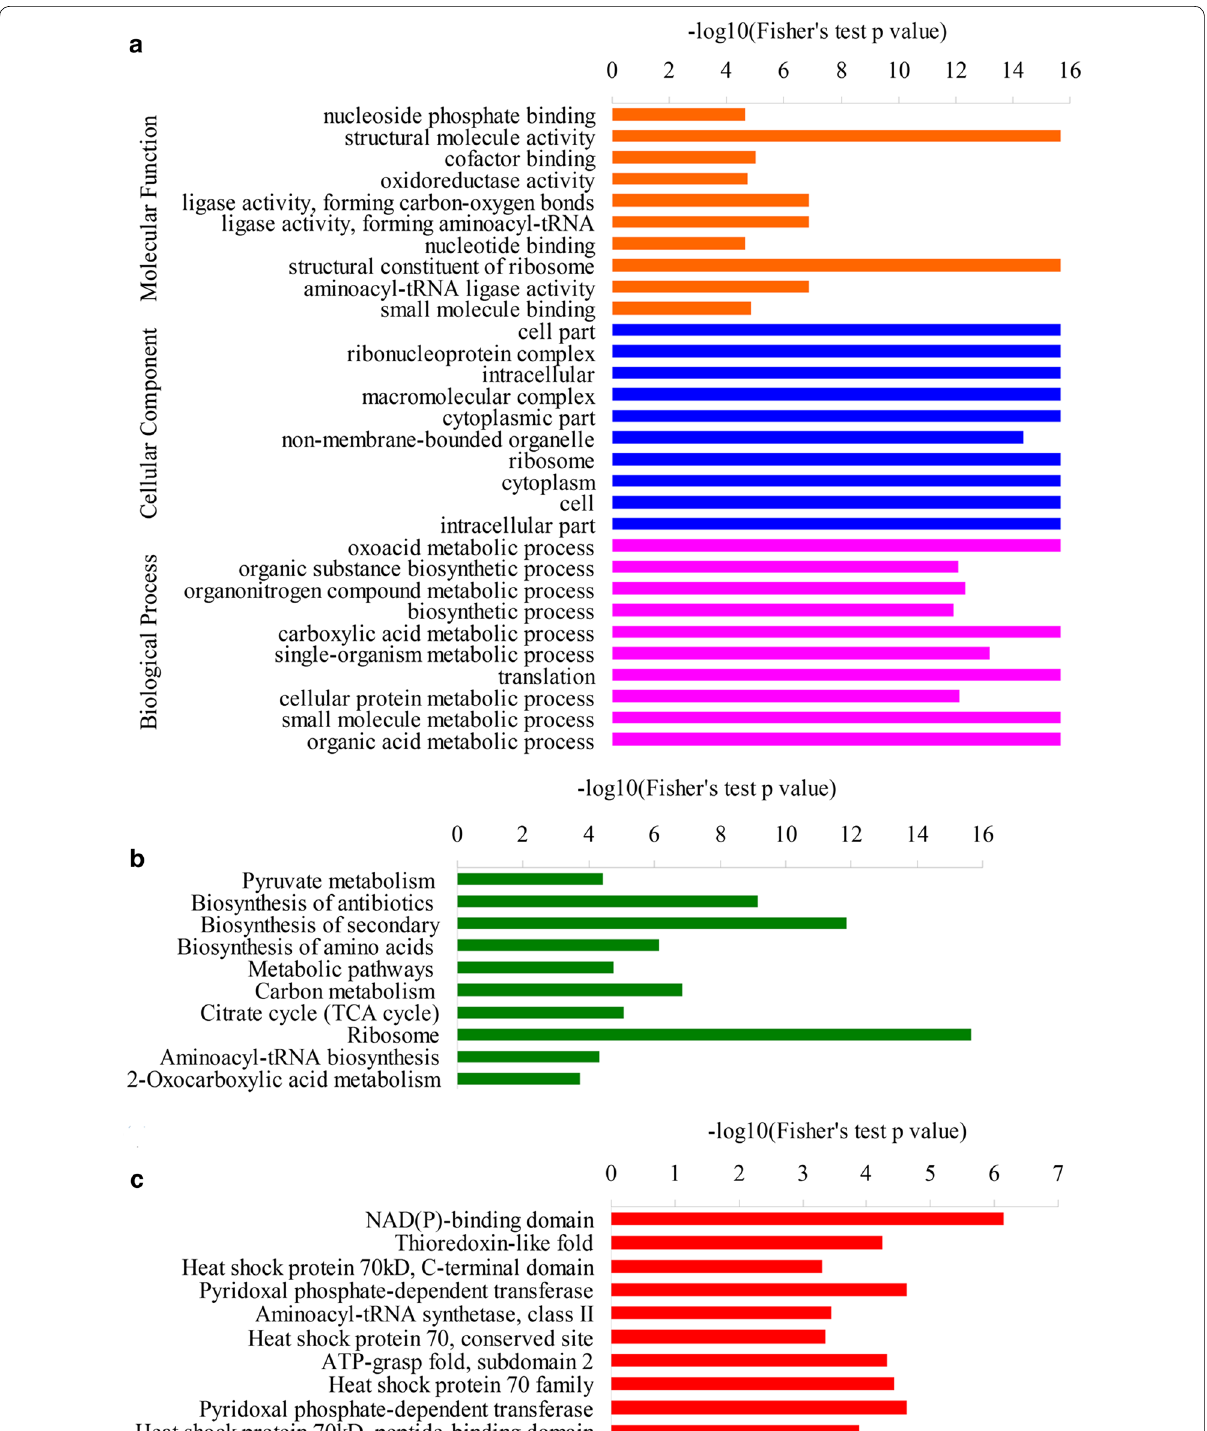
Fig. 7 Enrichment analysis of the acetylated proteins in Y. lipolytica . a GO-based enrichment analysis in terms of molecular function, cell compo- nent and biological process. b KEGG pathway-based enrichment analysis of the acetylated proteins. c Domain-based enrichment analysis of the acetylated